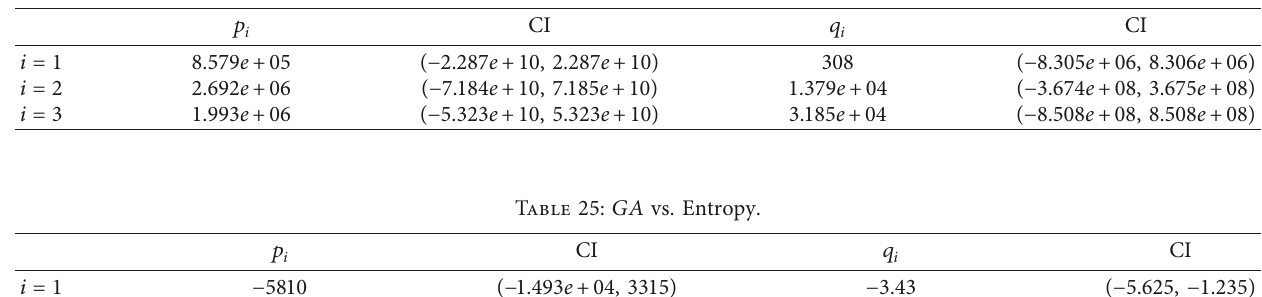
Table 24: ABC vs. Entropy.